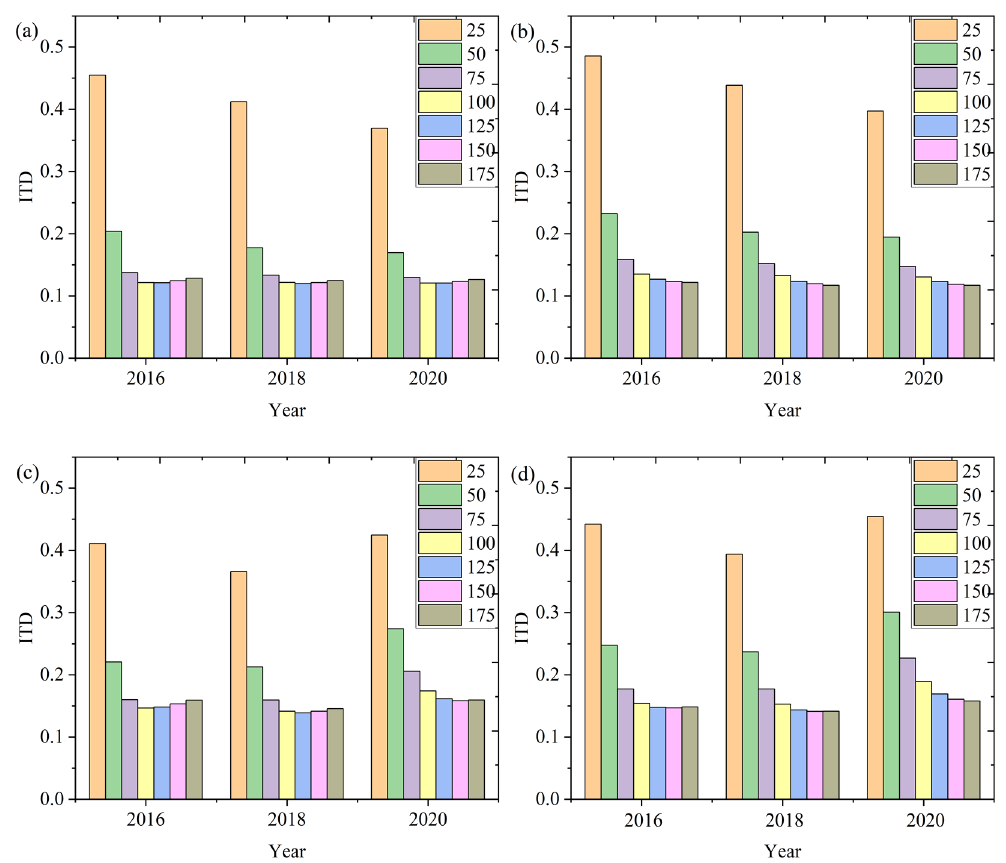
Figure 15. The performance of RSPD with different number of segments Q , where ( a ) is the ITD between RSPD and ShDI in Case I; ( b ) is the ITD between RSPD and SiDI in Case I; ( c ) is the ITD between RSPD and ShDI in Case II; and ( d ) is the ITD between RSPD and SiDI in Case II.